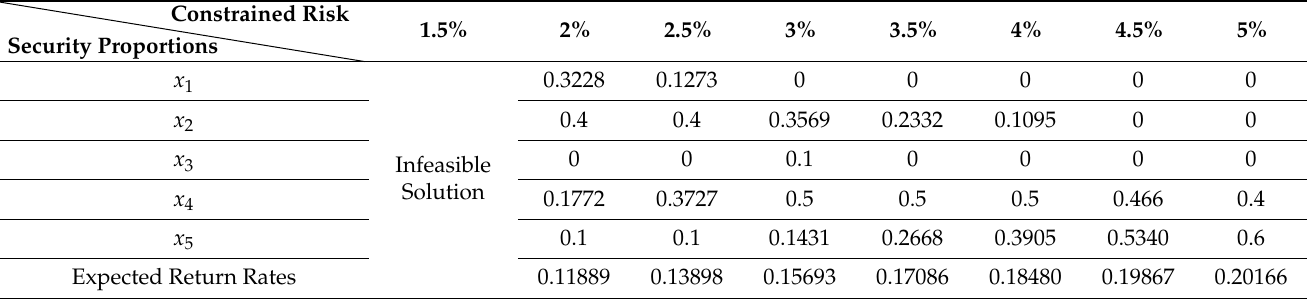
Table 8. The dimension with t = 2 and s = 2 with a guaranteed return rate (cid:101) p 2 in the proposed model.